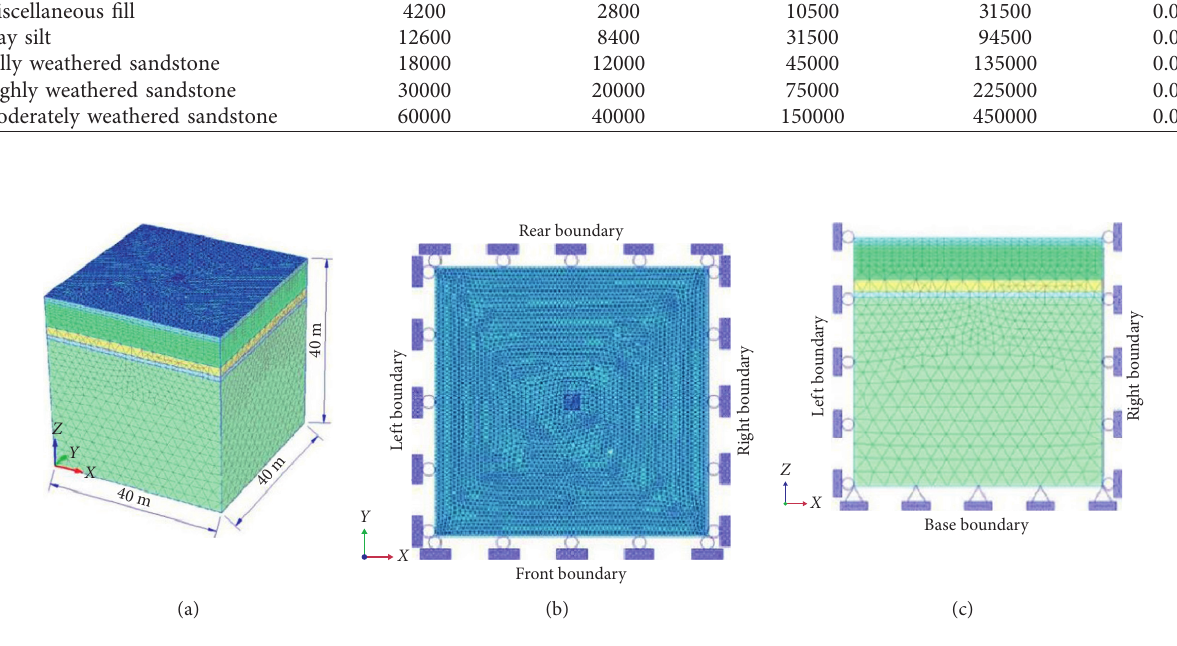
Figure 16: Three-dimensional model diagram. (a) Grid graph, (b) plane figure, and (c) front view.